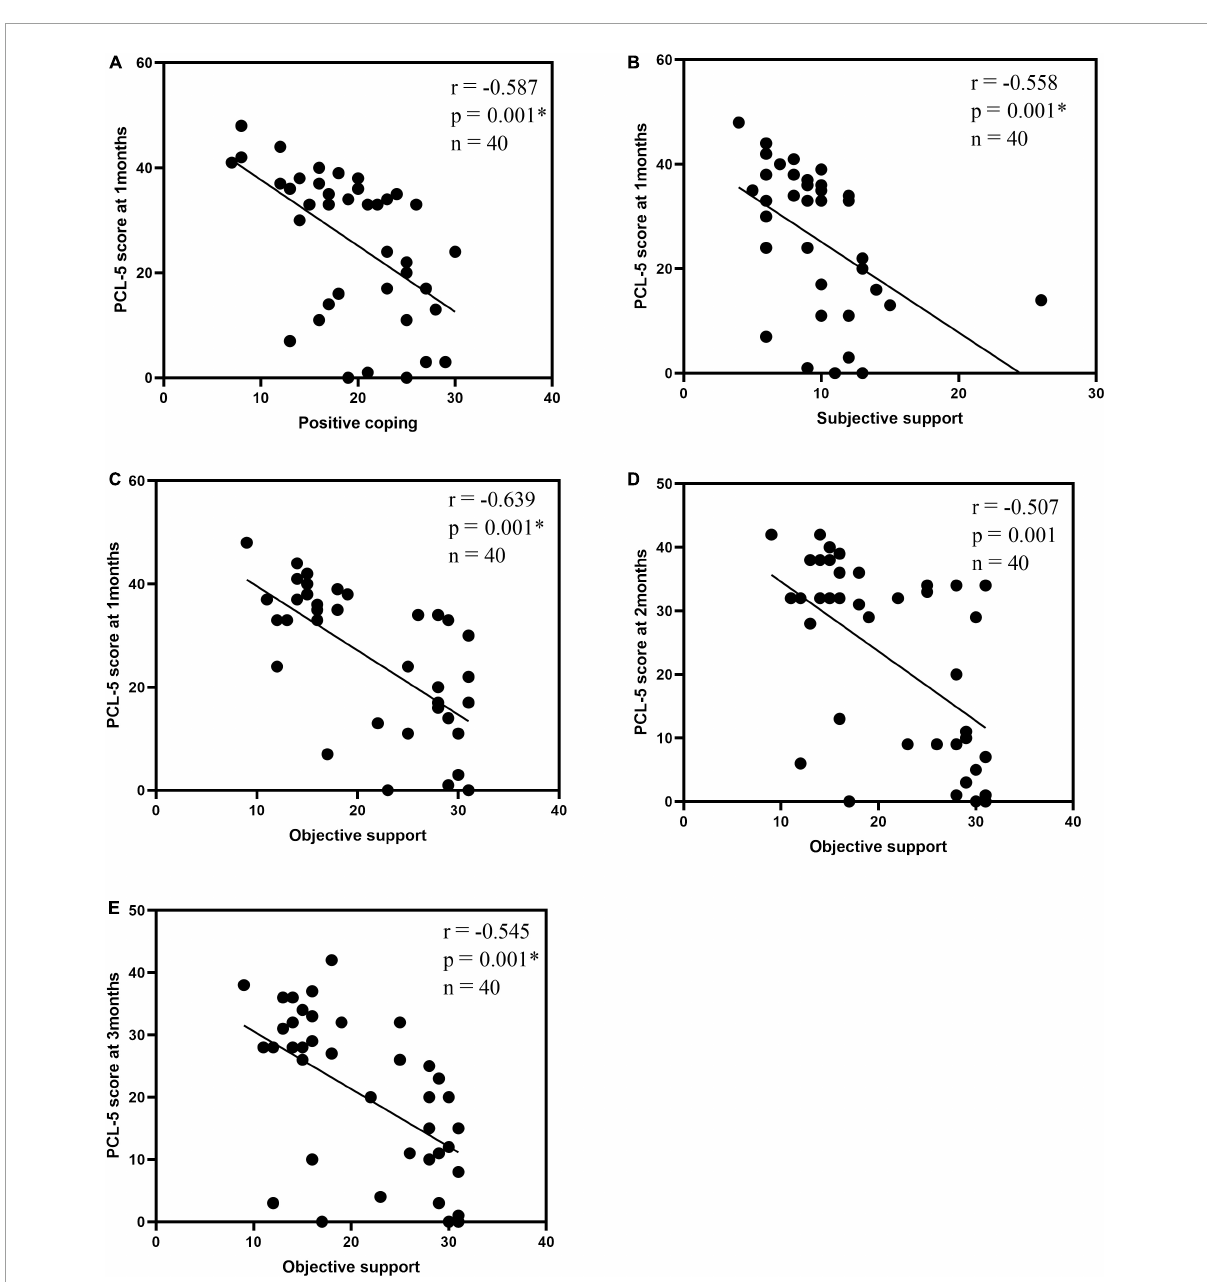
FIGURE4 Correlation analysis| between the total PCL-5 score and the SCSQ, SSRS dimensions: 1-month PCL-5 scores and positive coping (A) , subjective support (B) ; objective support and 1-month PCL-5 scores (C) , 2-month PCL-5 scores (D) , 3-month PCL-5 scores (E) . P < 0.003 was considered a statistically significant difference. * p <